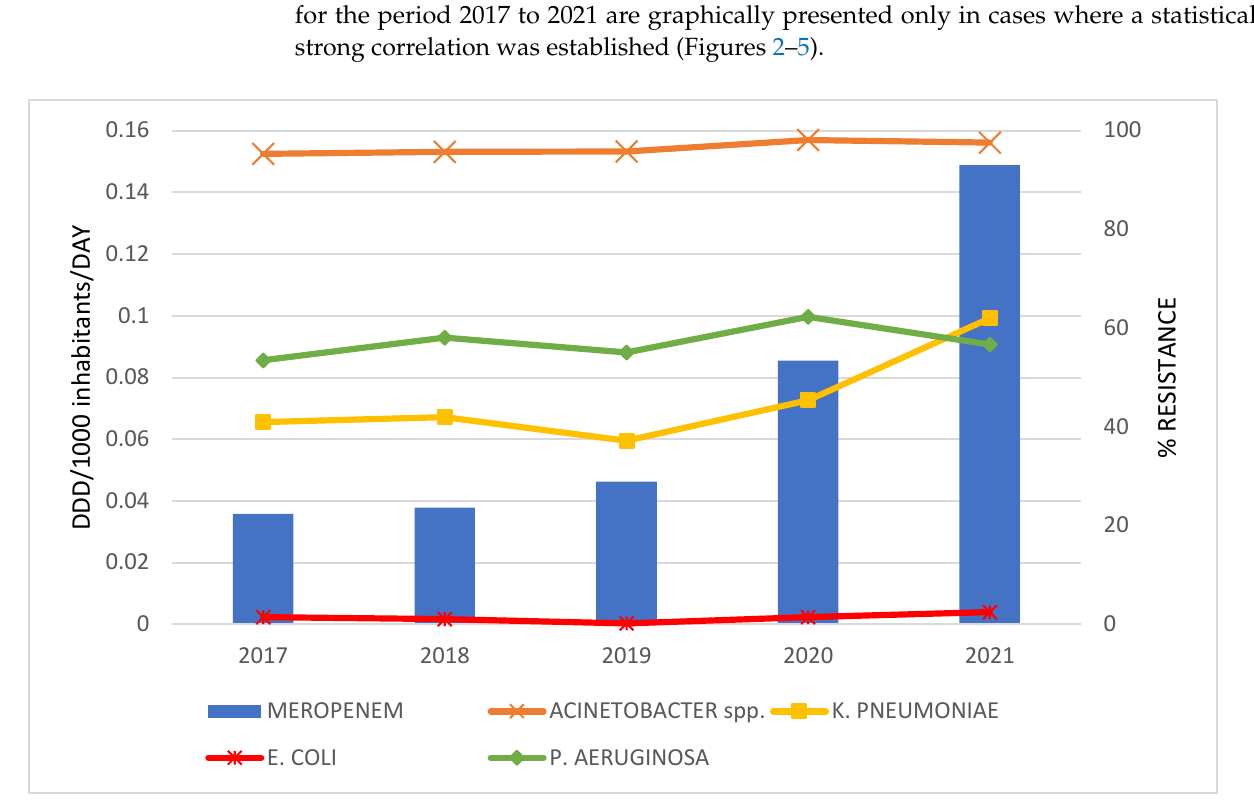
Figure 2. The correlation of meropenem consumption and the resistance to meropenem in bacteria during